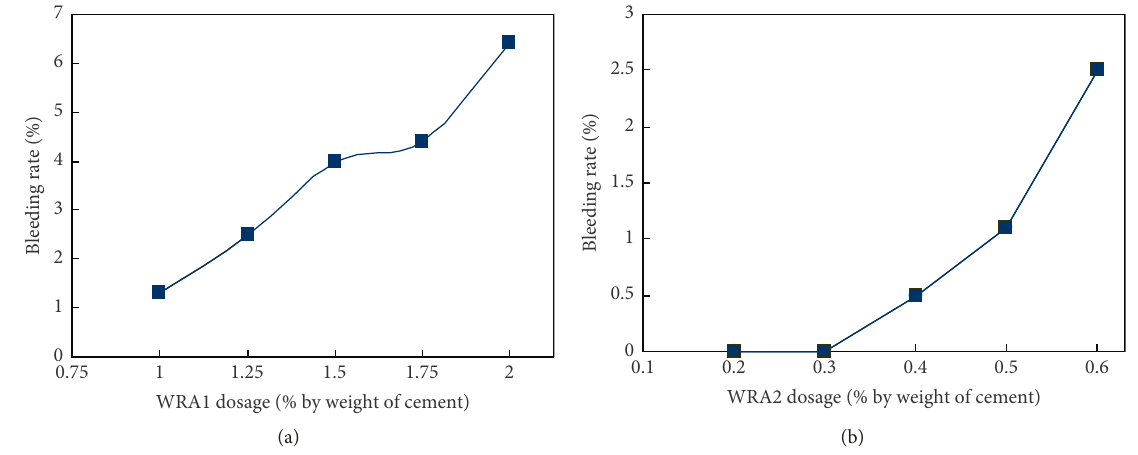
Figure 5: Bleeding index of CGCBM mixed with different dosage of